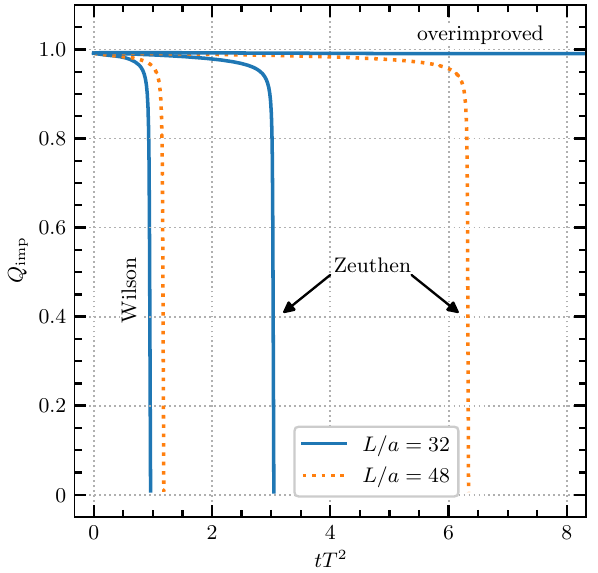
Fig. 5 IntegrandofEq.(25)at T / T c = 4for N τ = 6 , 8 , 10 , 12 , 16 , 20. The black solid curve represents the continuum case and corresponds to the integrand of Eq. (20) to an integer. The choice 1 / 2 corresponds to thresholding to the nearest integer. We therefore define the critical radius of a caloron where it becomes topological as Q imp (ρ crit ) ≡ 0 . 5 .